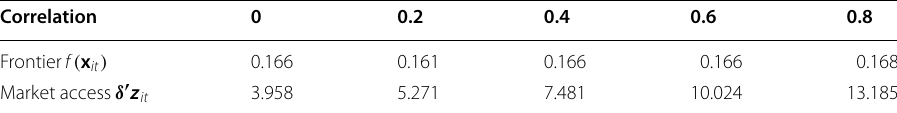
Table 1 Results from Monte Carlo analysis: MSE Correlation 0 0.2 Frontier f ( x it ) Market access δ ′ z